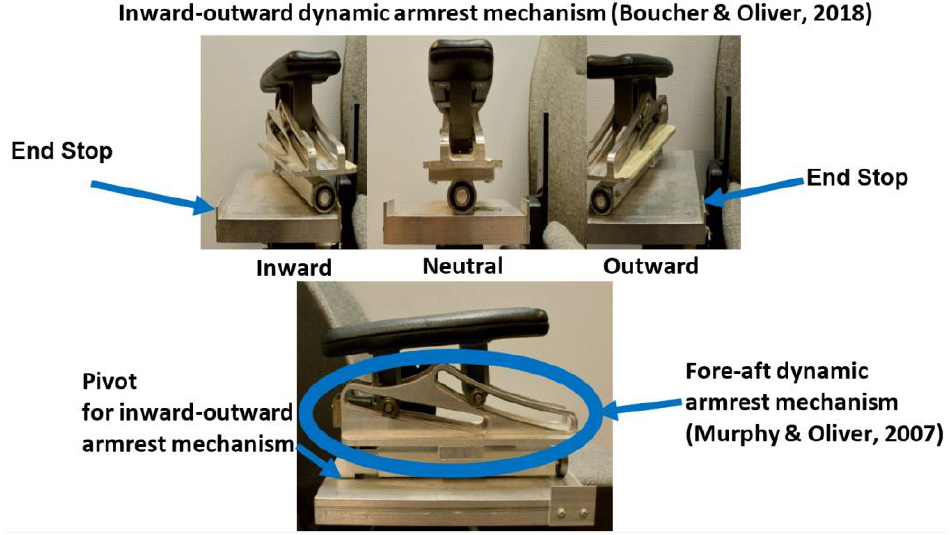
Figure 2. Horizontally dynamic armrest (DA) [28] mounted on top of fore – aft dynamic armrest [26,27]. Top figures — front views; bottom figure — side view. The joystick was instrumented with strain gauges which were used to determine when the joystick was in the neutral position and when it was being moved. Eight ¼ bridge strain gauges were configured into two full-bridge setups (EA-06-060PB-350, Measurements Group Inc., Micro-Measurements Division, Raleigh, North Carolina; re- sistance 350% ± 0.2% ohms; gauge factor 2.105% ± 0.5%; transverse sensitivity +0.7% ± 0.2%). Each full bridge setup was used to quantify movement in one axis (fore – aft, in- ward – outward). In each axis, forces in the fore and outward directions were positive strain (tensile), and those in the aft and inward directions were negative strain (compres- sive). Strain gauges were calibrated to assess operator force applications for the inward, outward, fore, and aft directions according to methods developed by Murphy and Oliver [12]. The joystick was positioned horizontally, and calibration data were collected by hanging masses (i.e., 0 kg, 0.4043 kg, 0.5347 kg, 0.6722 kg, 0.8051 kg, 0.9401 kg, 1.078 kg, 5 kg, 10 kg, and 15kg) for each joystick movement direction (fore, aft, inward, and outward). The calibration data were fit using a linear regression, resulting in four calibration equa- tions, one for each joystick movement direction (Figure 3). ( a )